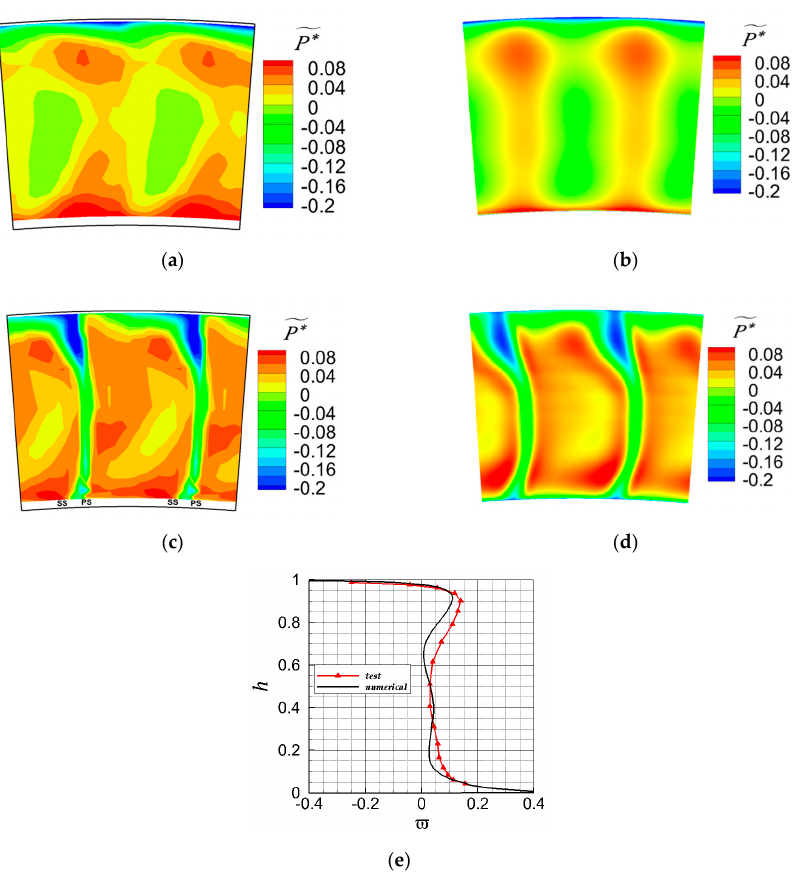
Figure 11. Test and numerical results of the third stator. ( a ) Normalized total pressure contour of the stator inlet of the test results. ( b ) Normalized total pressure contour of the stator inlet of the numerical results. ( c ) Normalized total pressure contour of the stator outlet of the test results. ( d ) Normalized total pressure contour of the stator outlet of the numerical results. ( e ) Comparison of the distribution of the total loss coe ffi cient of test and numerical